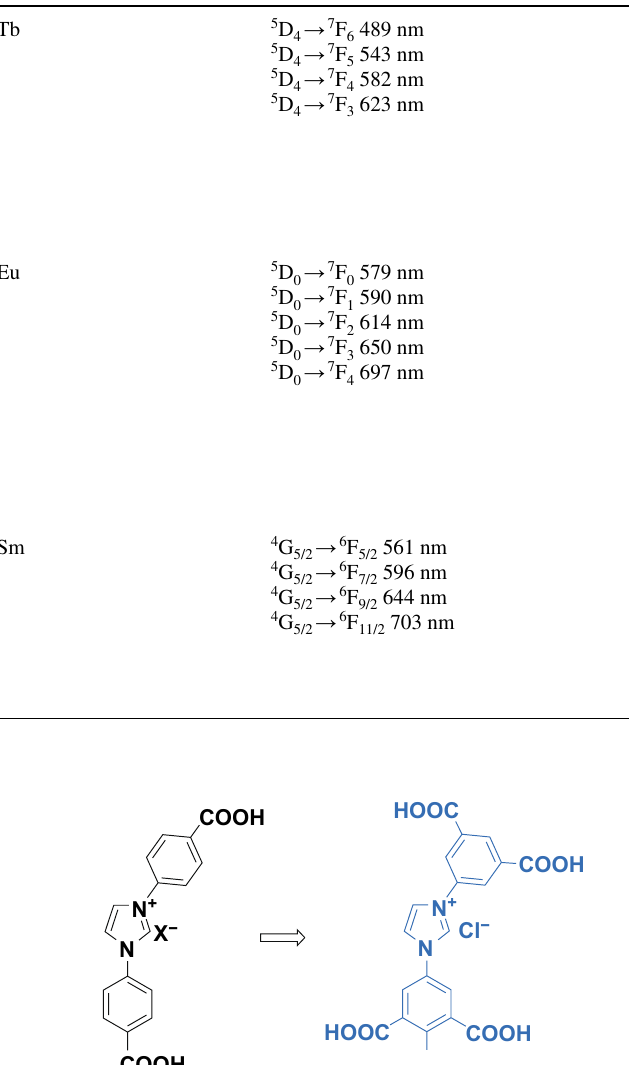
Table 2 Metals involved in MOFs to induce photoluminescence Metal centers